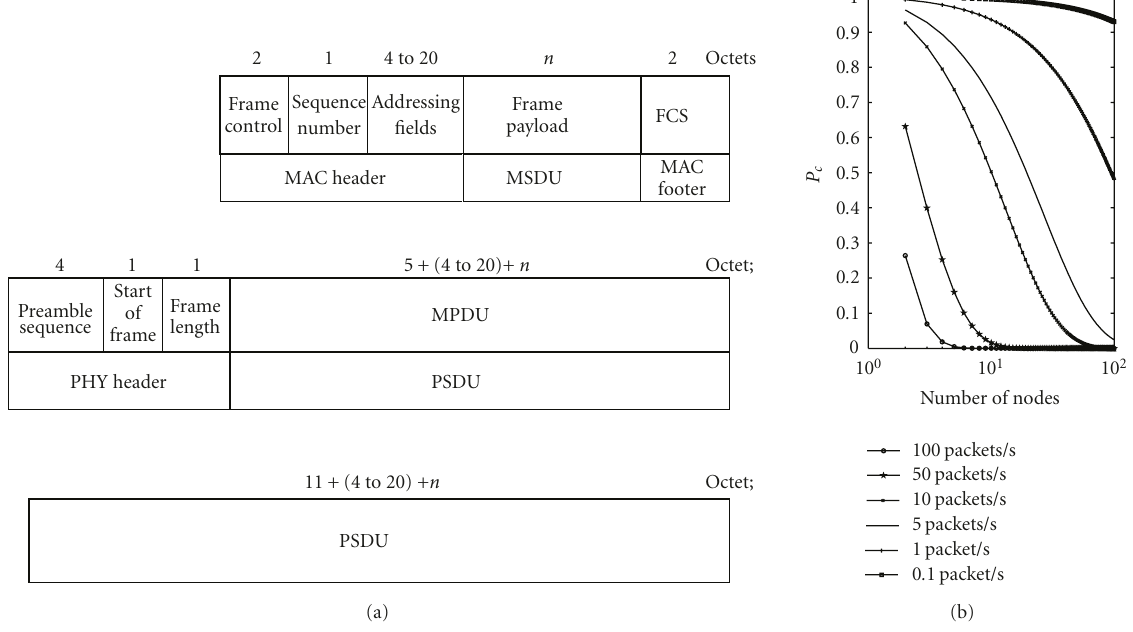
Figure 2: (a) IEEE 802.15.4 frame structure, (b) clear channel probability versus number of